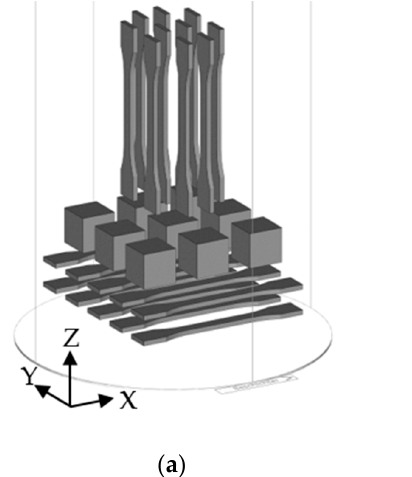
Figure 2. Illustration of the designed build job for the Sintratec S2 laser sintering system: ( a ) Orien- tation and placement of the test specimens in the building platform. The XYZ-specimens were oriented horizontally and the ZYX-specimens were oriented vertically. The coating direction was in the X-direction and the layer build-up in the Z-direction; ( b ) macroscopic images of sinter material and test specimen: (b.1) printing powder or aged powder; (b.2) cube; (b.3) tensile bar.